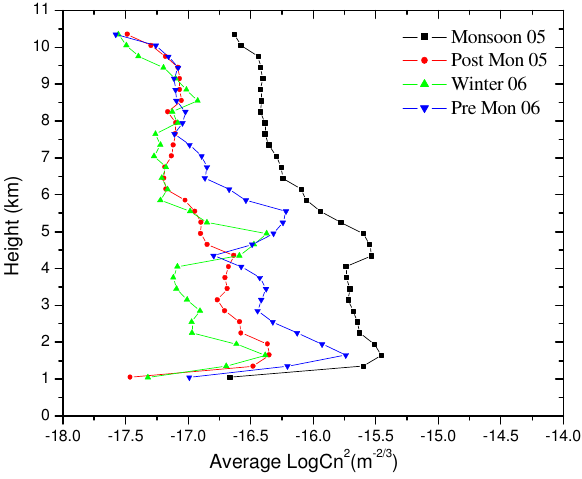
Fig. 5. Height profile of mean Log C 2 n for different seasons, year 2003–2004.